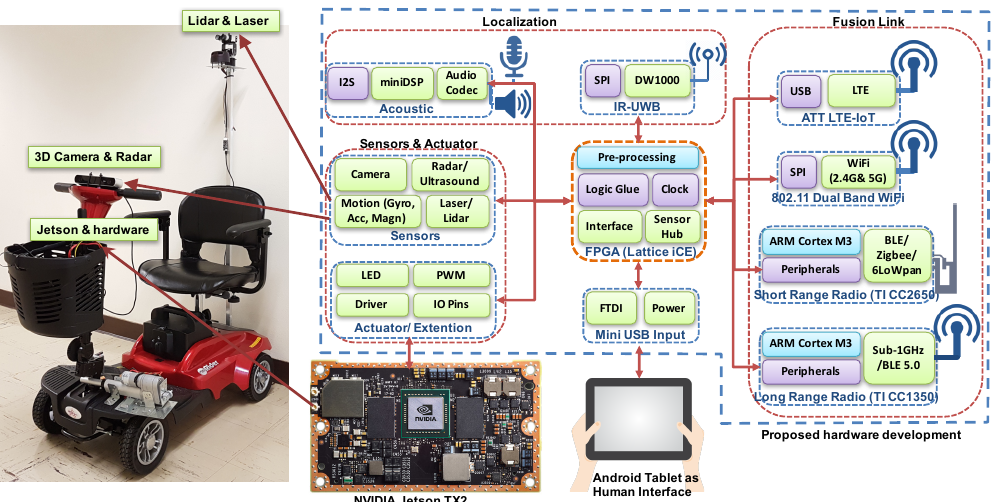
Figure 3. The architecture of the computing, sensing and communication